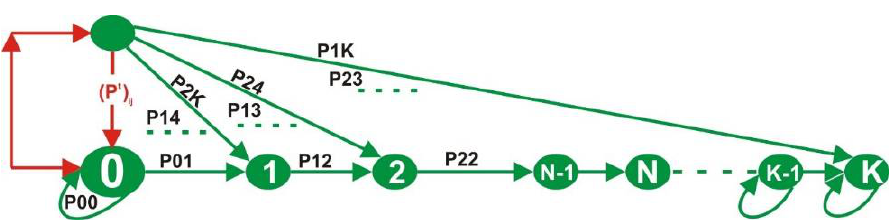
Figure 4. The transition process of X n .